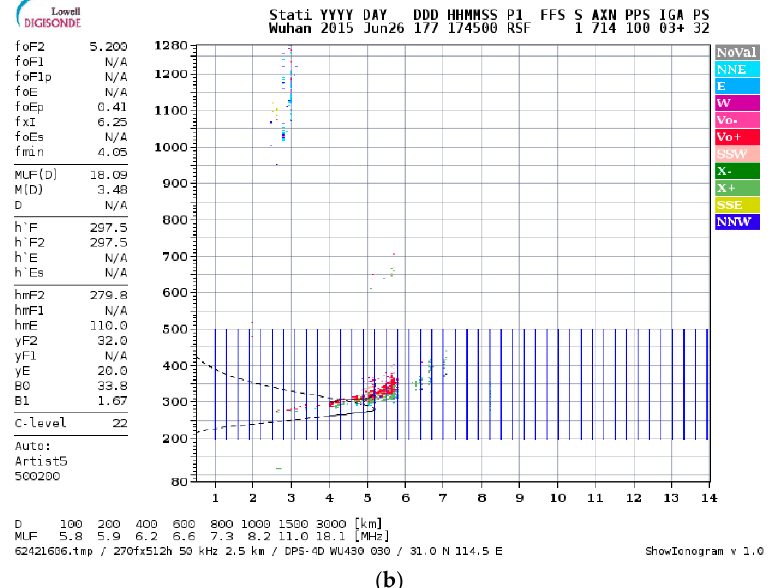
Figure 2. ( a ) An example of consecutive points (feature value) extraction positions in ionogram without SF in Mohe at 03:15UT on 9 January, 2017. ( b ) An example of consecutive points (feature value) extraction position in ionogram with SF in Wuhan at 17:45UT on 26 June 2015.